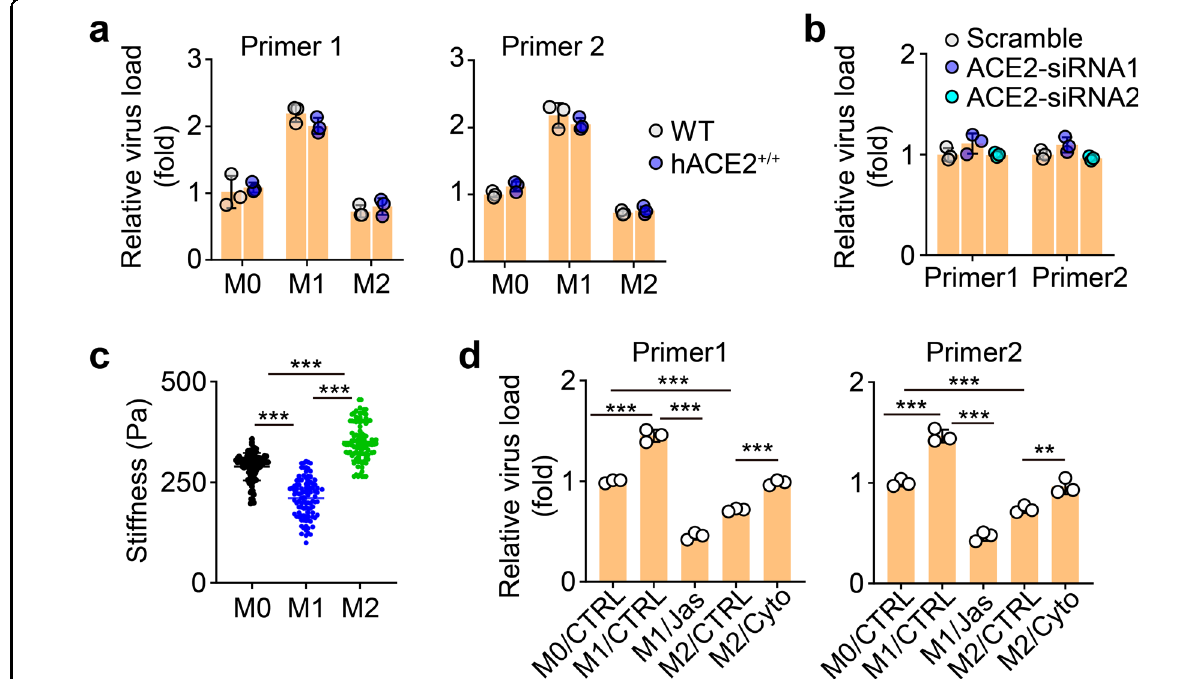
Fig. 3 Softness facilitates M1 AMs to take up viruses. a AMs isolated from WT or hACE2 mice were infected with SARS-CoV-2 for 2 h. The viral load was analyzed by qPCR. b The virus load from ACE2 -siRNAs AMs was determined by qPCR. c The stiffness of M0, M1, and M2 AMs was measured by atomic force microscopy. d M1 or M2 AMs were treated with jasplakinolide (Jas, 50 nM) or cytochalasin D (Cyto, 1 μ M) for 12 h or 4 h,